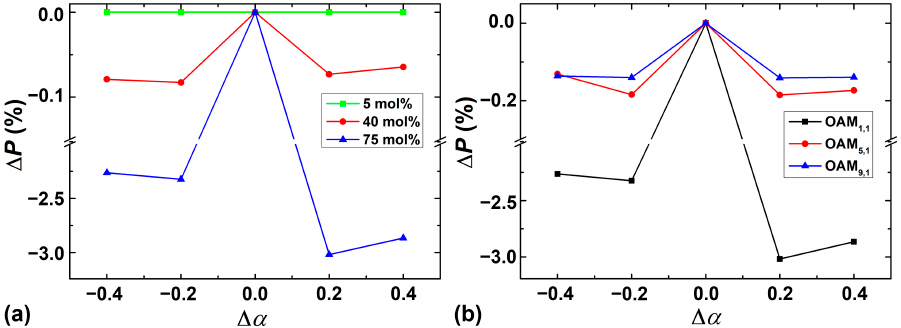
Figure 9. Purity deviation ∆ P as a function of ∆ α with ( a ) different mole fractions of GeO 2 for OAM 1,1 mode, and ( b ) different OAM modes from OAM 1,1 to OAM 9,1 for 75 mol% GeO 2 mole fraction.